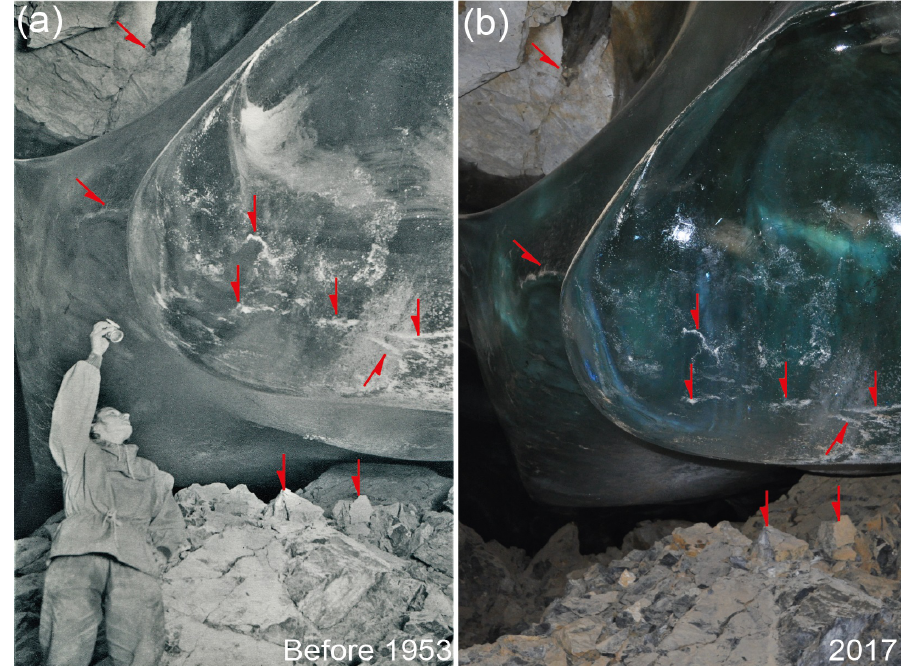
Figure 7. (a) Photo of the ice body located in room G taken shortly before 1953 (Casteret, 1953). (b) Photo taken in 2017. In both pictures, white patches on the ice surface correspond to small CCC accumulations released from the ice by sublimation. Red arrows indicate common features in both